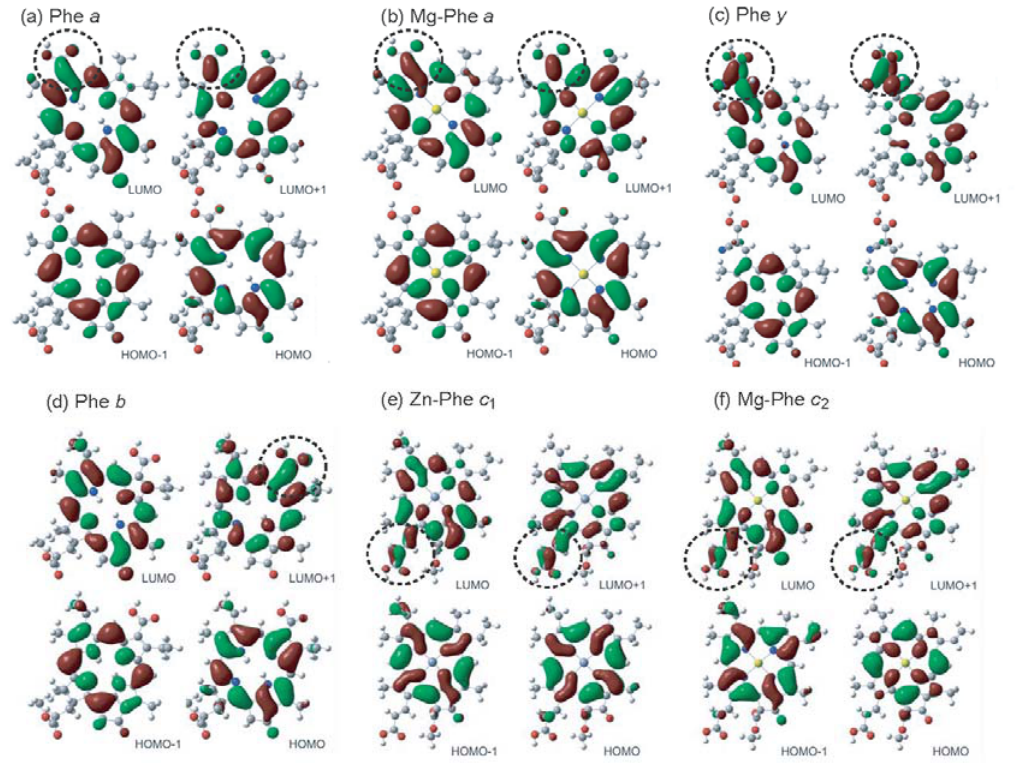
Figure 46. The four orbitals including HOMO–1, HOMO, LUMO and LUMO + 1 obtained by TD-DFT